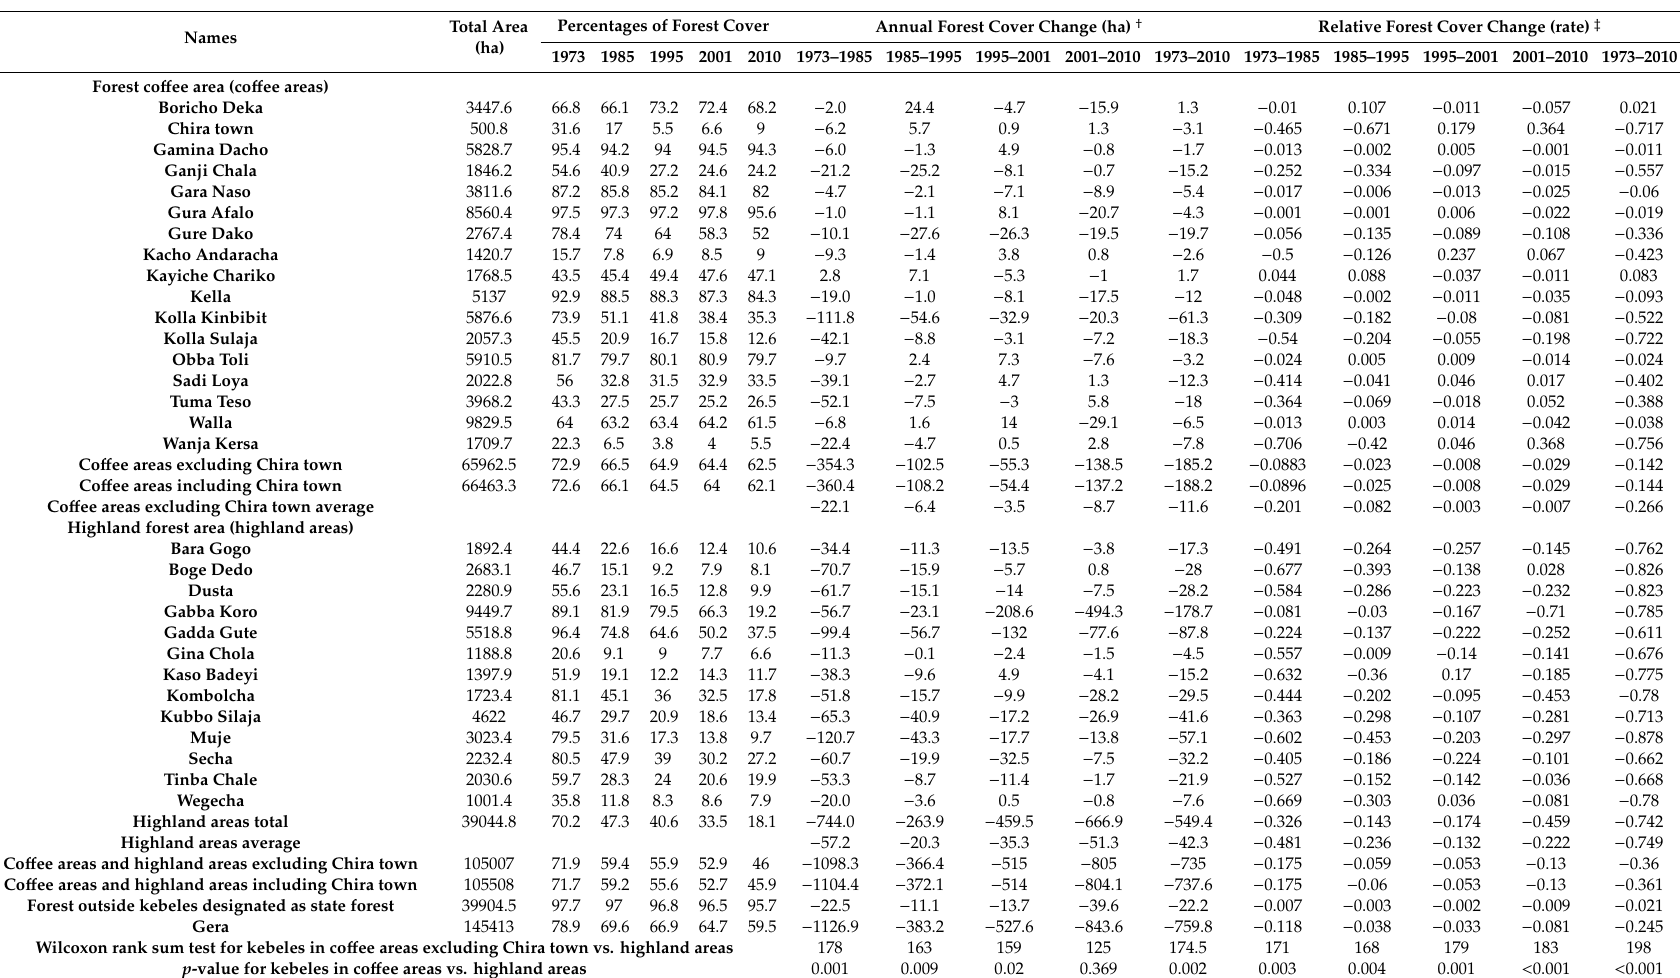
Table A2. Forest cover and patterns of forest cover changes in kebeles located in highland and co ff ee forest areas in Gera from 1973 to